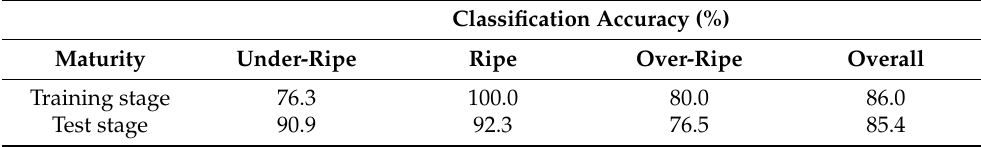
Table 8. The classification accuracy of the training stage and test stage for